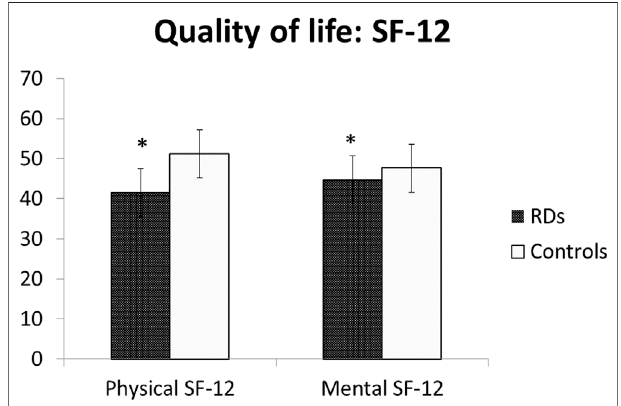
FIGURE3| QualityofLifeinRDs patients versuscontrolgroup. Legend: RDs: Rheumatic diseases.